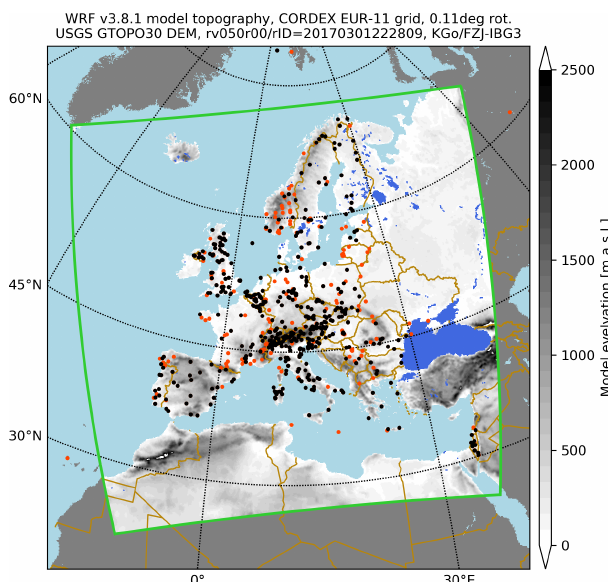
Figure 2. Overview of European ecological research site locations for which data are provided based on the EURO-CORDEX RCM ensemble. Dots: black: eLTER sites; red: other DEIMS-registered European LTER sites. Green line: delimiter of the RCM focus do- main as defined in the EURO-CORDEX project; EUR-11 grid: 424 × 412 grid elements. The topography in grey is taken from a WRF RCM (Knist et al., 2018) and based on the USGS GTOPO30 (USGS, 2020) global elevation dataset.